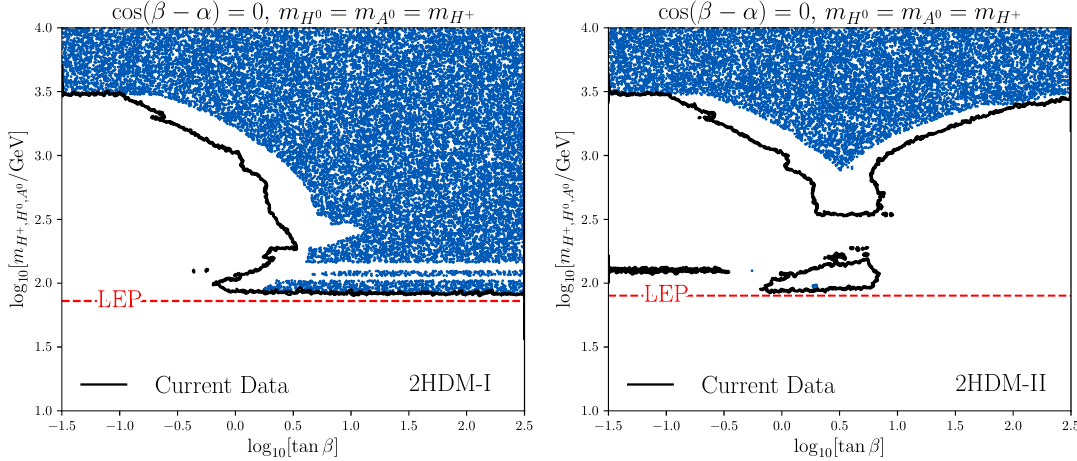
Figure 13 . Scan of 50000 randomly generated points compared against LHC data, extrapolated to an integrated luminosity of 3 ab − 1 using 2HDecay and HiggsBounds , with allowed points shown in blue and the current data exclusion contour in black. On the left, the scan in the 2HDM-I, on the right the 2HDM-II.